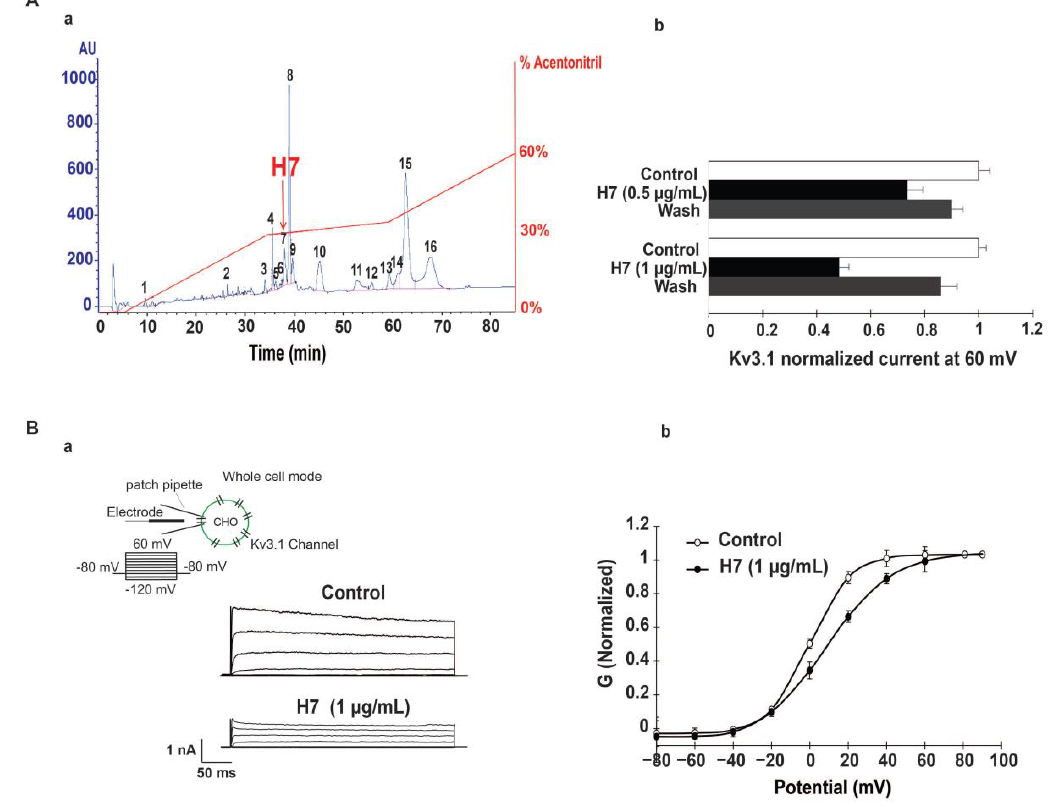
Figure 3. Characterization of H7 inhibitory effect on Kv3.1. ( Aa ) HPLC purification of AahG50 venom fraction (F5) obtained with FPLC method. Fifty micrograms of F5 were loaded per run on a C18 column reversed phase HPLC and 18 fractions (H1 to H18) eluted at a flow rate of 1 mL/min, using a multi-step gradient (90 min) from 0 to 60% of buffer B (0.1% TFA in CH3CN) in buffer A (0.1% TFA in water). ( Ab ) Kv3.1 normalized current at +60 mV shown before, and after perfusion of H7 at 0.5 and 1 µ g/mL and after washing. ( Ba ) Whole-cell currents, recorded in mammalian cells, elicited by the application of 250 ms depolarizing pulses from − 120 mV, to +60 mV in 20 mV increments, from a holding potential of − 80 mV, under control conditions and after the addition of 1 µ g/mL of H7. ( Bb ) The normalized conductance (G) voltage relationship of Kv3.1 current plotted under control conditions and after the perfusion of 1 µ g/mL of H7. The 18 fractions obtained with HPLC were examined for their ability to inhibit Kv3.1 current. Only, subfraction number 7, eluted at 37.9 min Figure 3A(a), reduces Kv3.1 current as described in Figure 3B(a). All other subfractions affect neither the amplitude nor the kinetics of the currents. Using IV protocol (Figure 3B(a)), we found that H7 reduces IKv3.1 in a concentration- dependent manner with 51 ± 0.2% and 25 ± 0.5% of inhibition at 1 µg/mL and 0.5 µg/mL, respectively (Figure 3B(b)). The inhibition is sustained in presence of H7 and was partially reversed upon washing (Figure 3A(b)). H7 at 1 µg/mL diminishes Kv3.1 current amplitudes with a rightward shift and slowing down of the steady state activation curve. Indeed, H7, 1 µg/mL produces a positive shift, of 11.94 ± 0.3 mV in V 1/2 , and increases the slope factor value (Figure 3A(b) and Table 1) but it does not modify the activation threshold (n = 20) (Figure 3B(b) and Table 1).